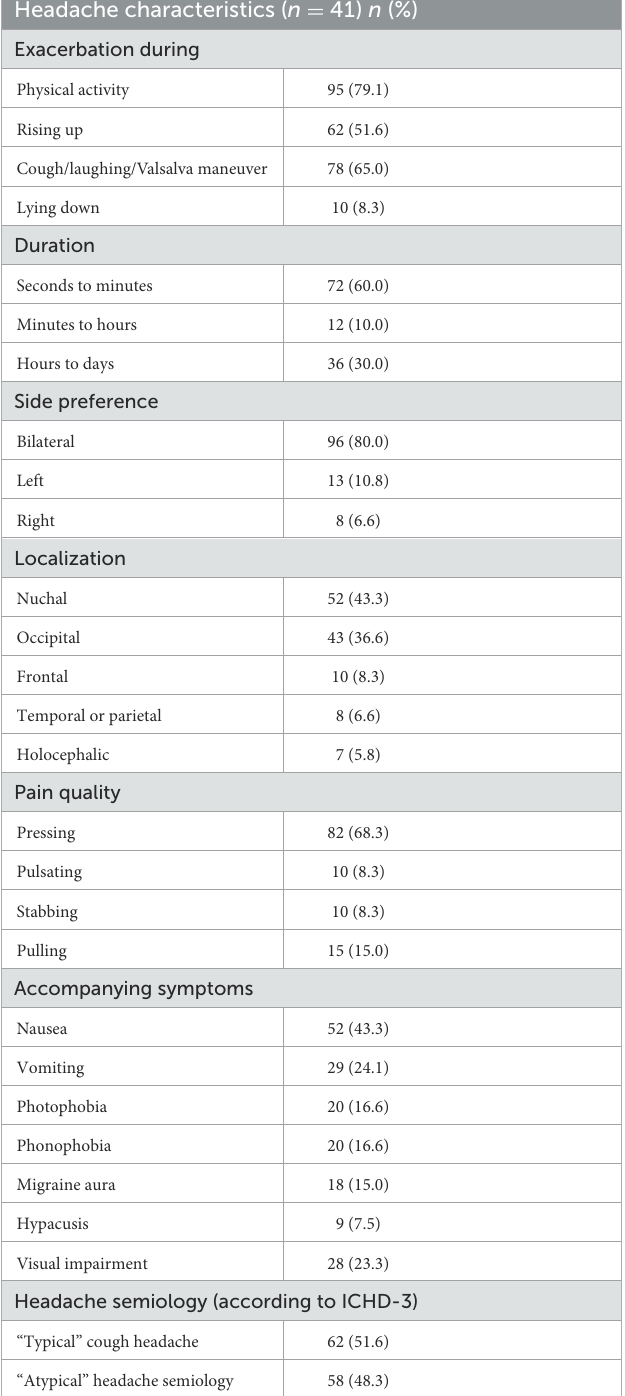
TABLE 6 Baseline headache characteristics ( n = 120). TABLE 7 Variation of mean ONSD, headache intensity scores and CCOS